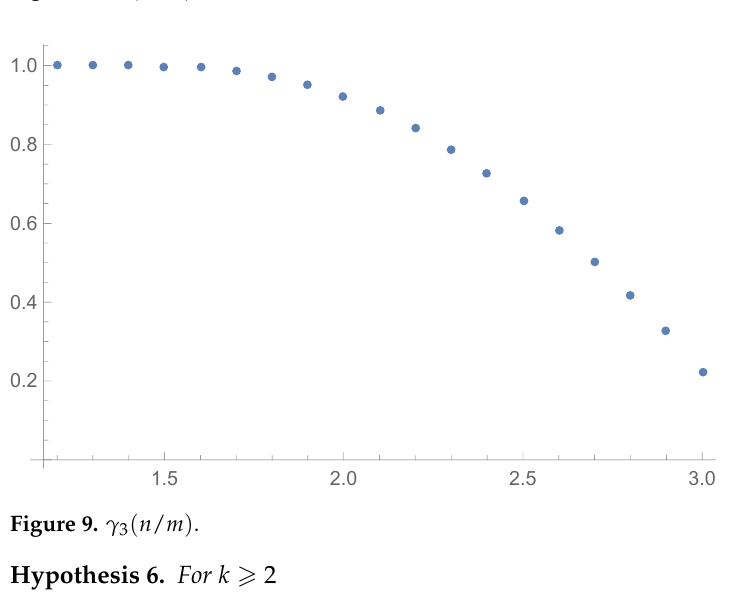
Figure 8. λ 3 ( n / m ) .